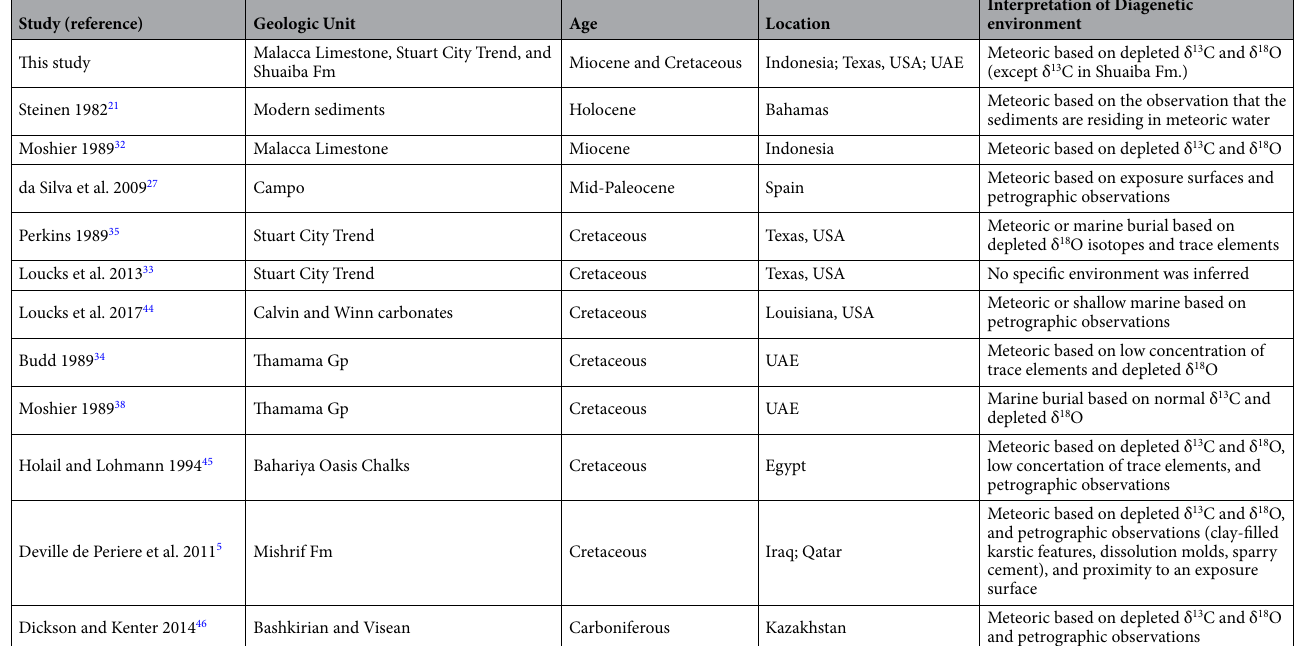
Table 1. Studies that report rhombic calcite microcrystals in Phanerozoic